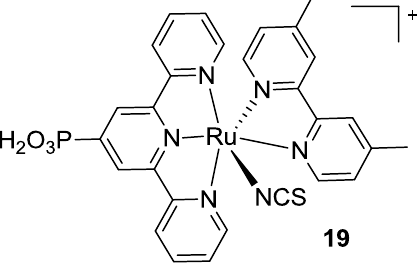
Figure 14. First example of tpy Ru-complex showing a bipyridine instead of two thiocyanates [25].